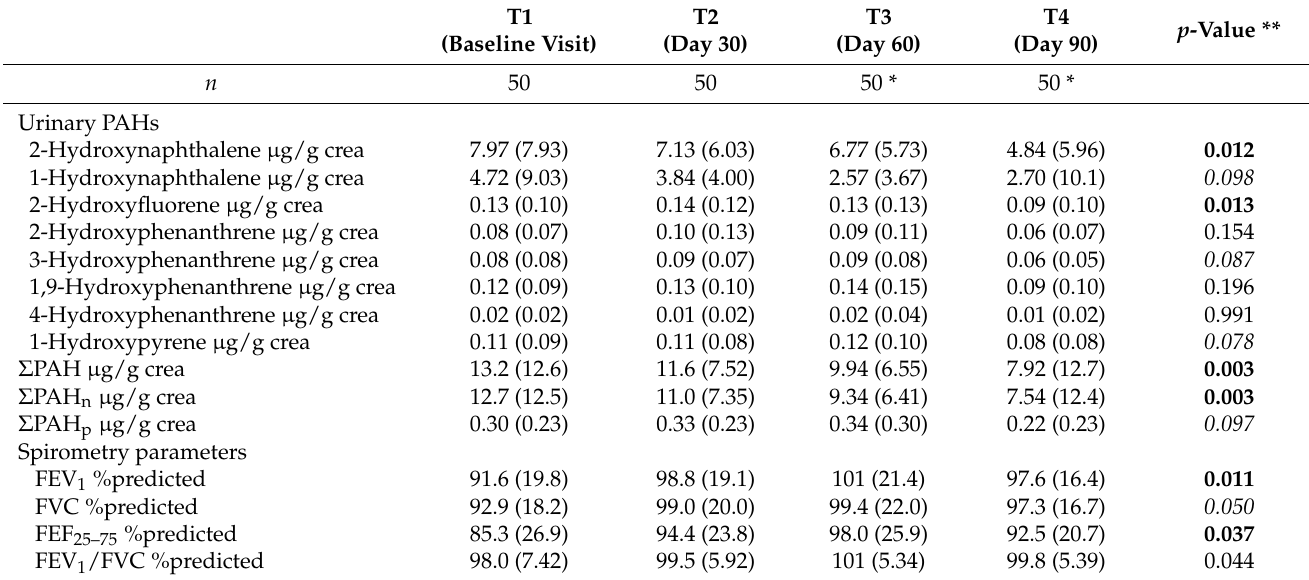
Table 3. Urinary PAHs and spirometry parameters along visits, during the study period (March and July 2017).